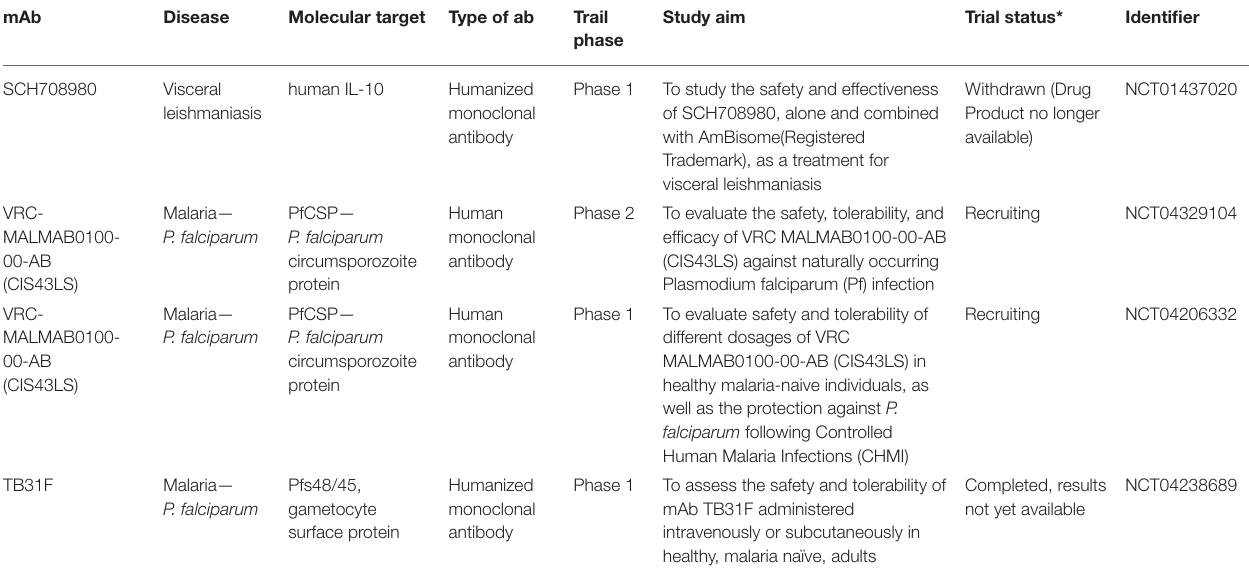
TABLE 2 | mAb evaluated in clinical trials for protozoan diseases treatment.